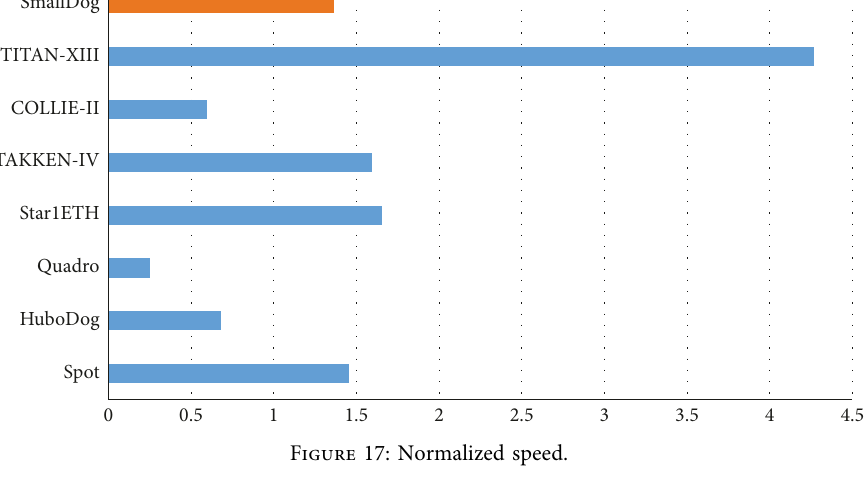
Figure 17: Normalized speed.